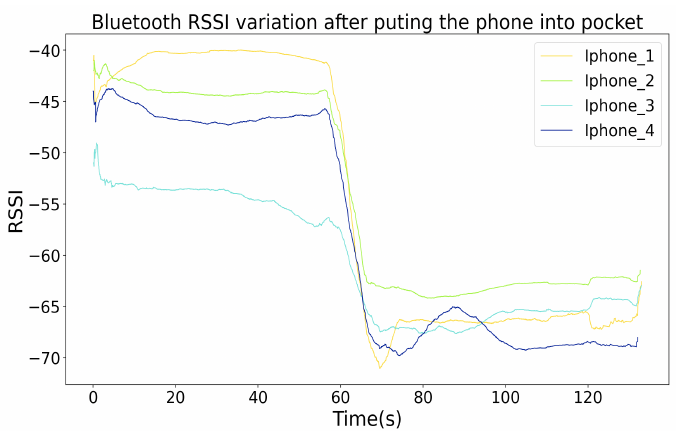
Figure 27. RSSI changed significantly after putting the BT RSSI sampling Iphone into the